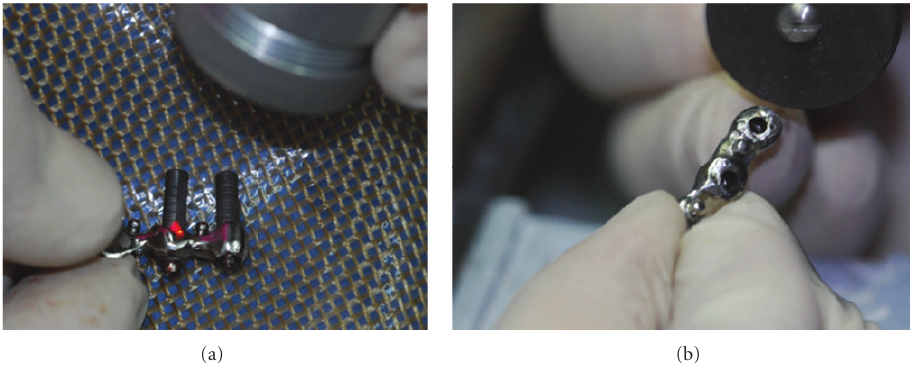
Figure 4: (a) The welding procedure extraorally completed by the same device. (b) The abutment cut by